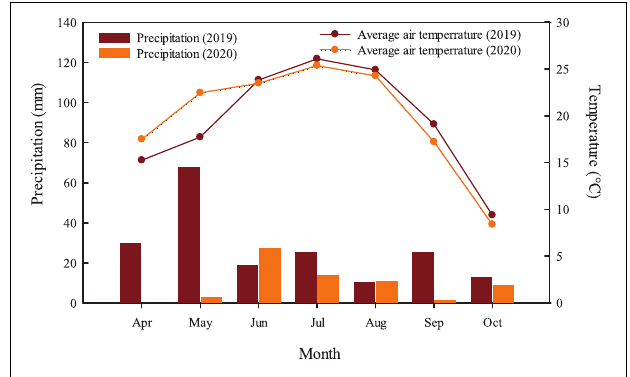
FIGURE 1 | Month average air temperature and rainfall in growth period of cotton in 2019 and